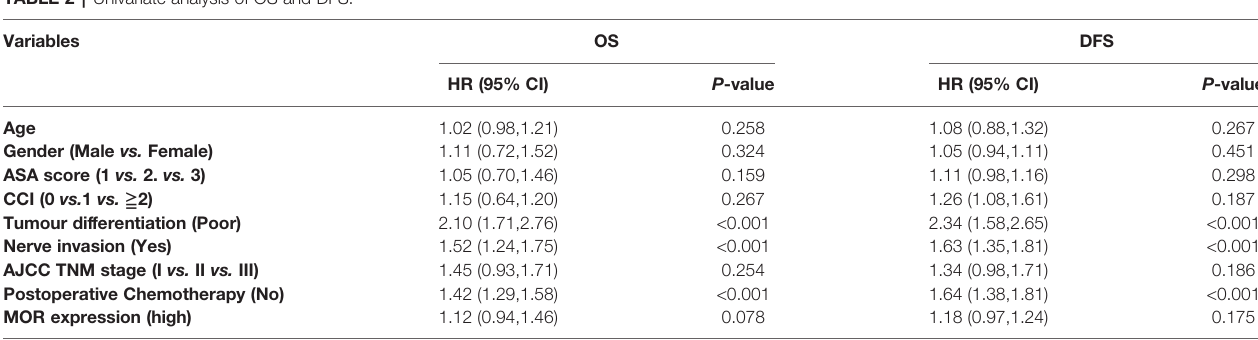
TABLE 2 | Univariate analysis of OS and DFS.